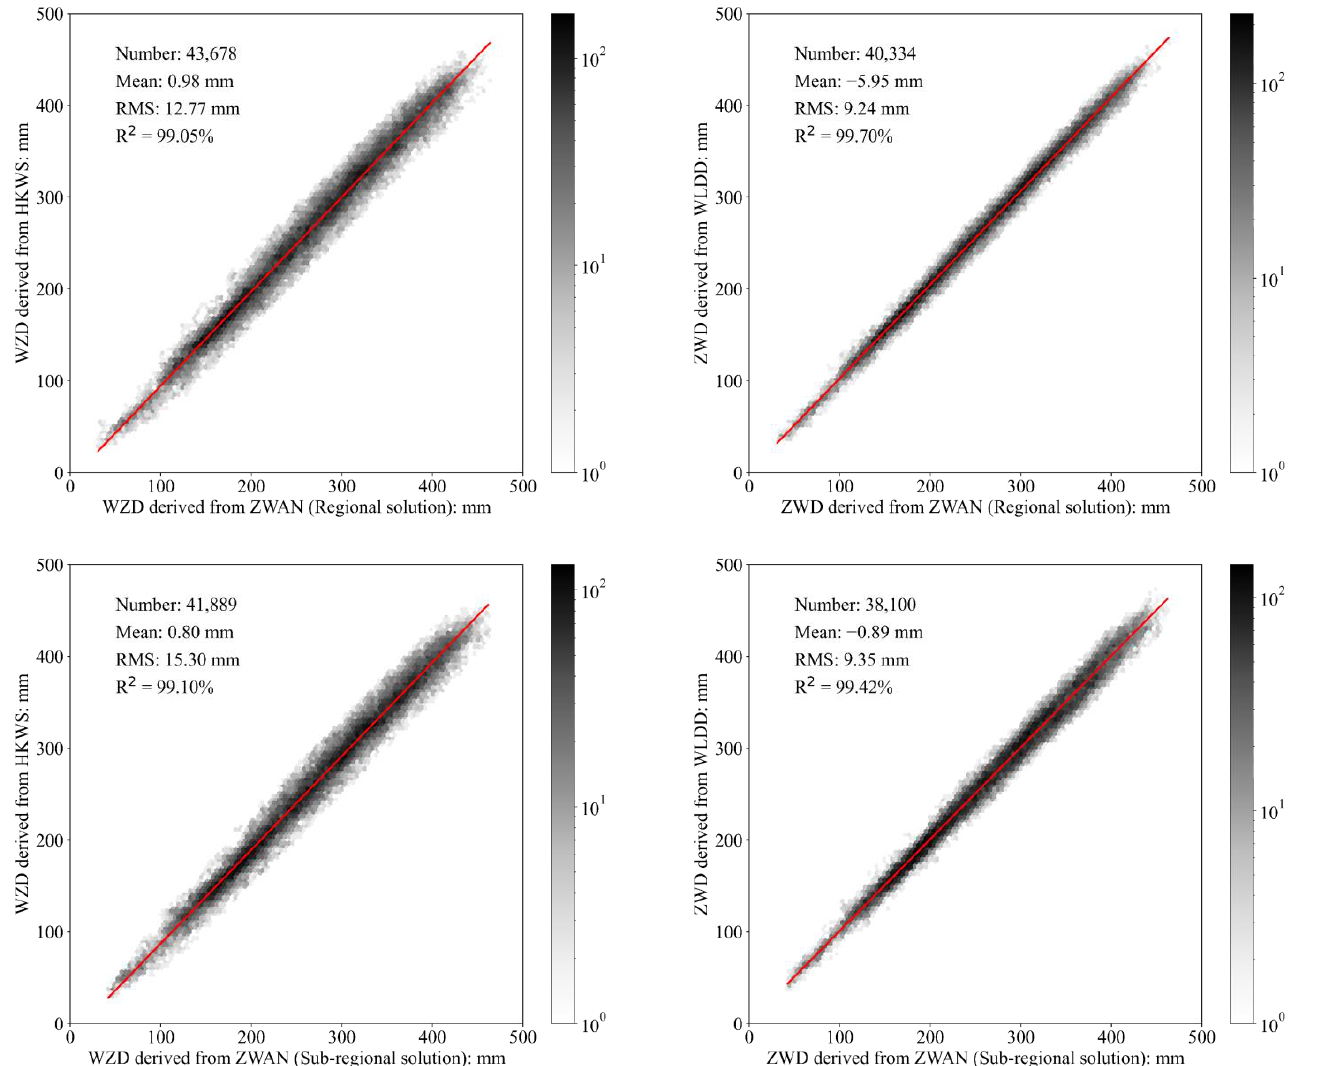
Figure 10. Comparisons of regional ( top ) and sub-regional ( bottom ) ZWD derived from different PGSs in the WSCS, including ZWAN, WLDD, and HKWS.